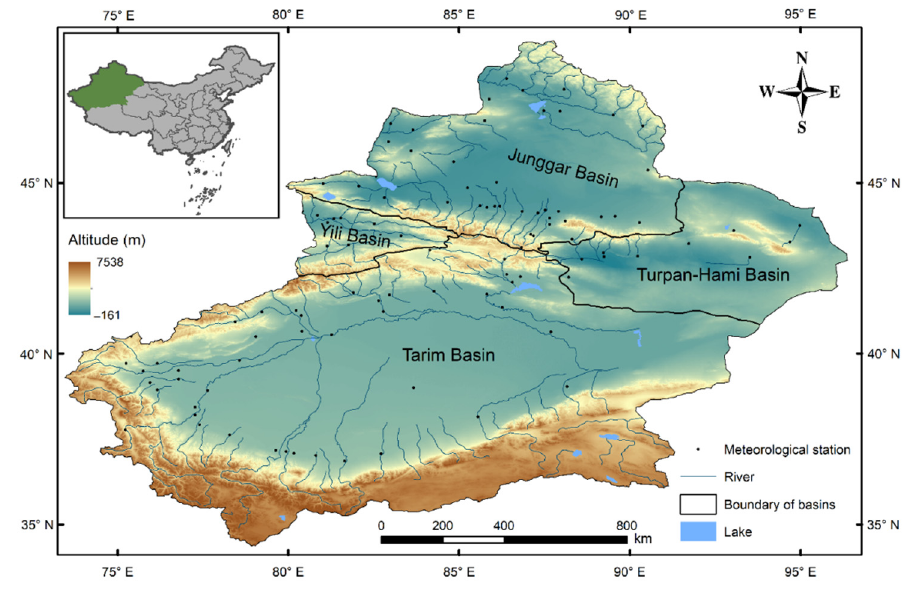
Figure 1. Study area description.